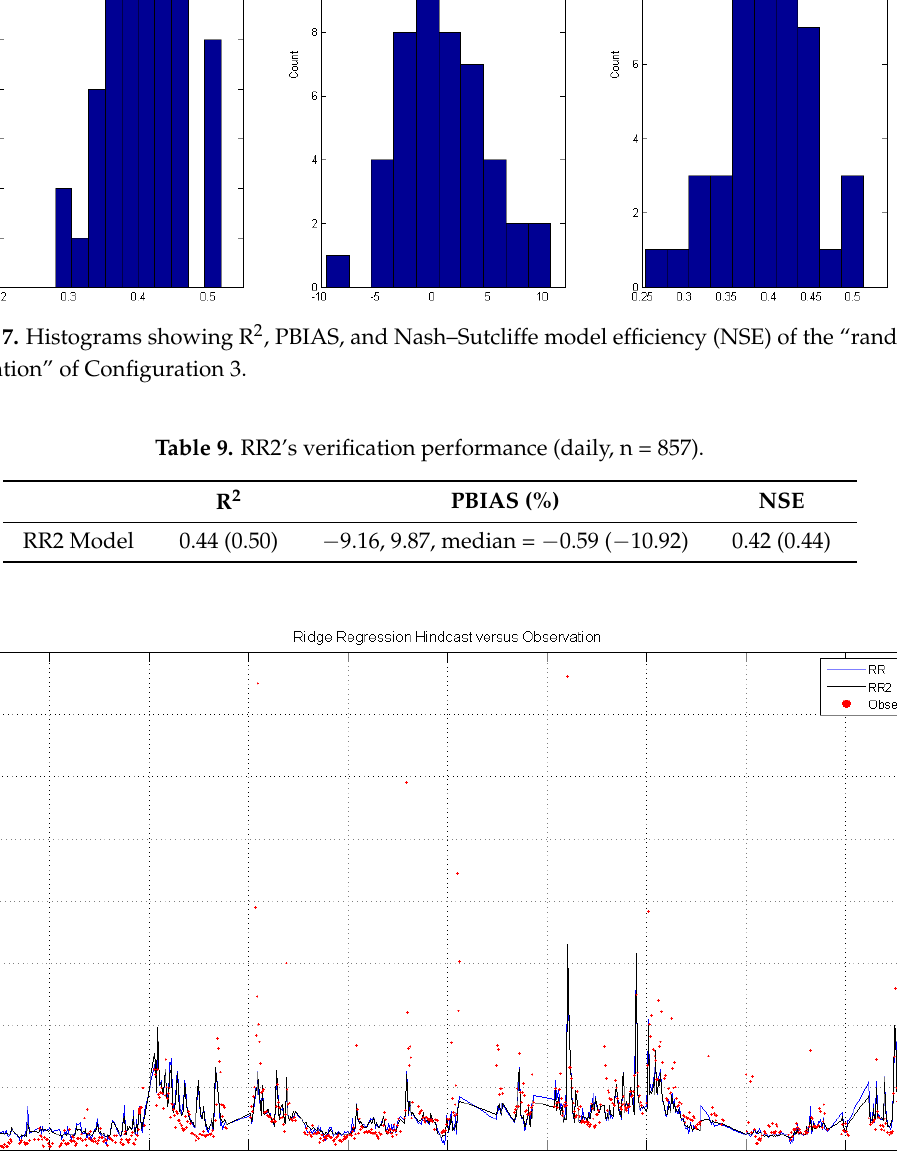
Figure 8. The hindcasts made by ridge regression models are compared with observations.